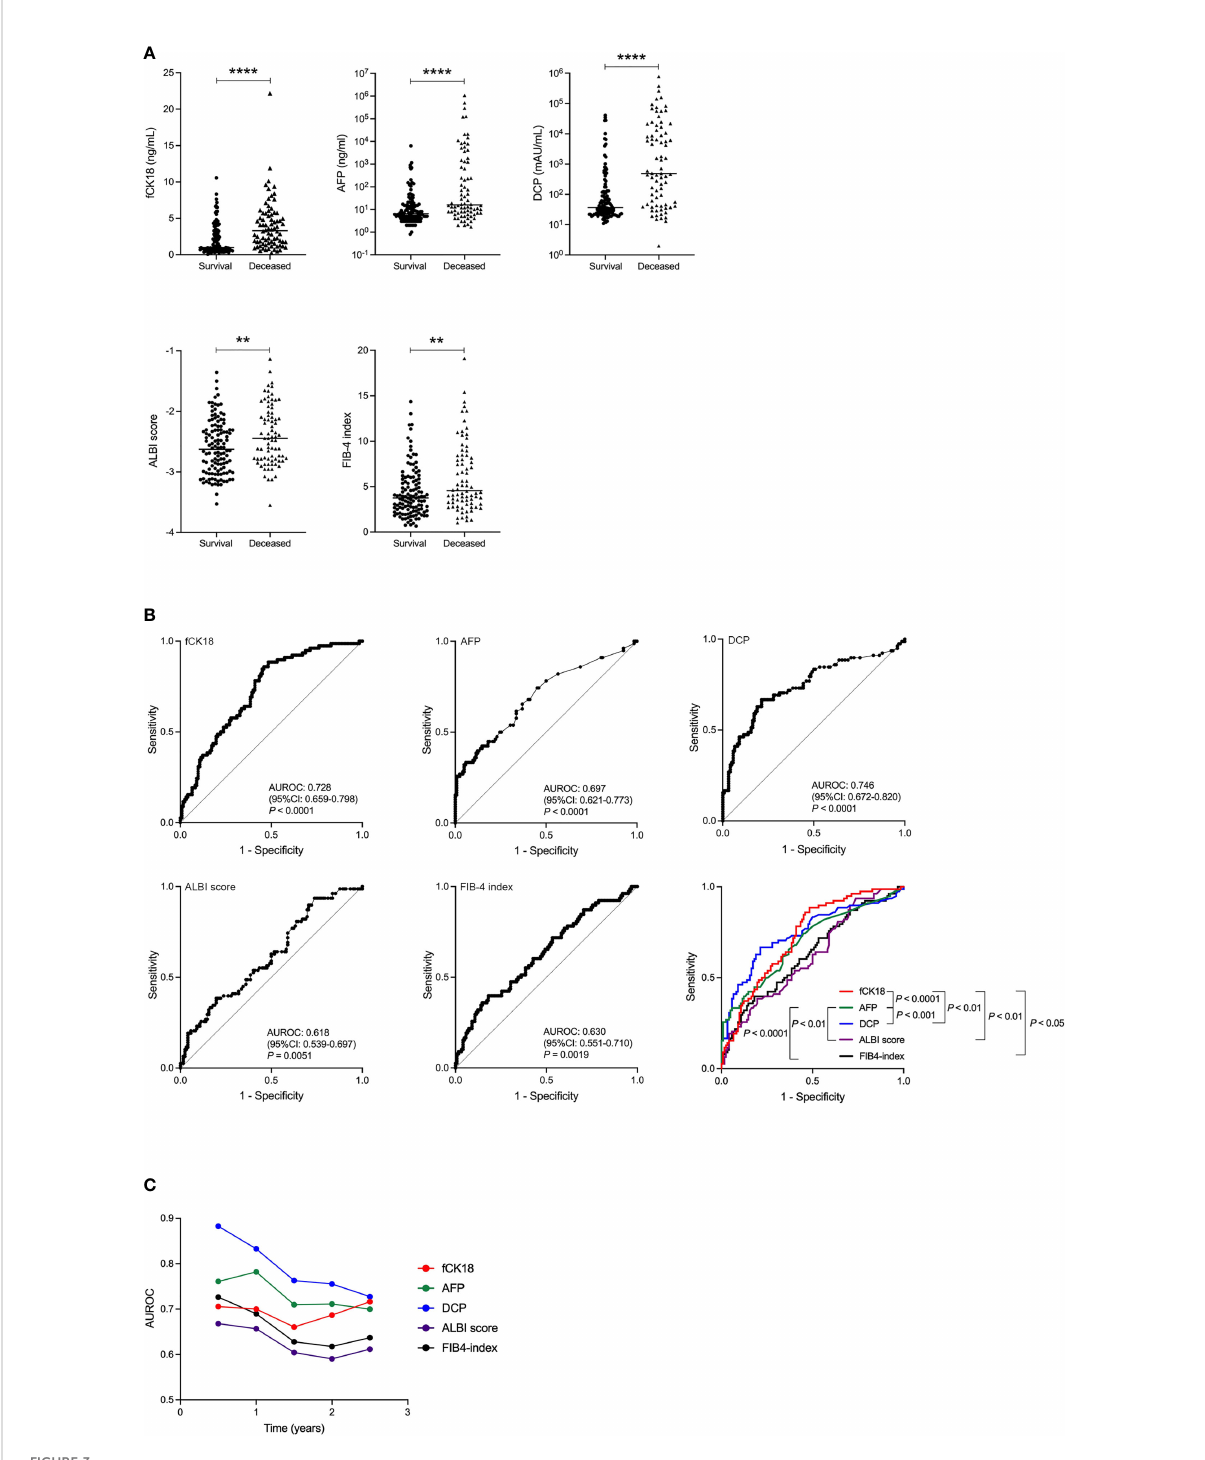
FIGURE 3 Survival rate improved in HCC patients indicated by serum fCK18 levels. (A) Serum fCK18, AFP and DCP levels, as well as ALBI score and FIB-4 index, in Survival and Deceased groups in HCC cohort. (B) ROC curve of serum fCK18, AFP and DCP levels, as well as ALBI score and FIB-4 index. ROC curve of all fi ve factors. (C) Plots of 0.5 year AUROC for serum fCK18 levels, AFP, DCP, ALBI score and FIB-4 index. ****p<0.0001, **p<0.01. fCK18, fragmented cytokeratin 18; AFP, alpha-fetoprotein; DCP, des-gamma-carboxy prothrombin; ALBI, albumin-bilirubin; FIB-4, fi brosis-4; AUROC, area under receiver operating characteristic